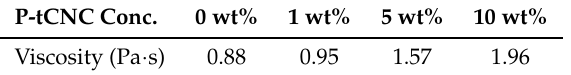
Table 1. The viscosity of PU/P-tCNC solutions in DMF increases with increasing P-tCNC concentration. P-tCNC Conc.